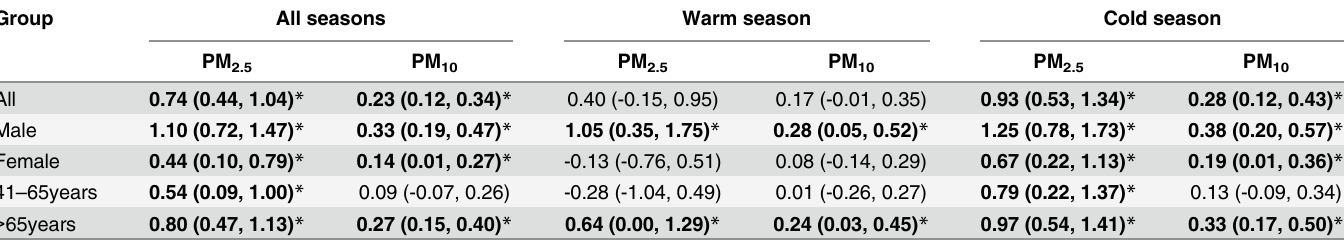
Table 2. Estimated percent difference in CHD outpatient and emergency department visits (95% CI) in association with a 10 μ g/m 3 increase in PM 2.5 and PM 10 at lag 01 by season, gender and age